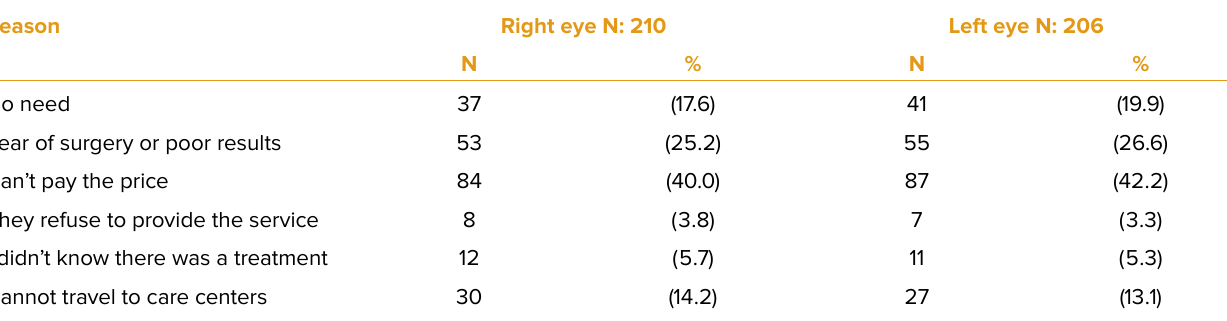
Table 5. Reason why adult patients 50 years or older had not undergone surgery considering themselves blind from cataract, Honduras, 2018–2019 ( N : 210/206) Reason